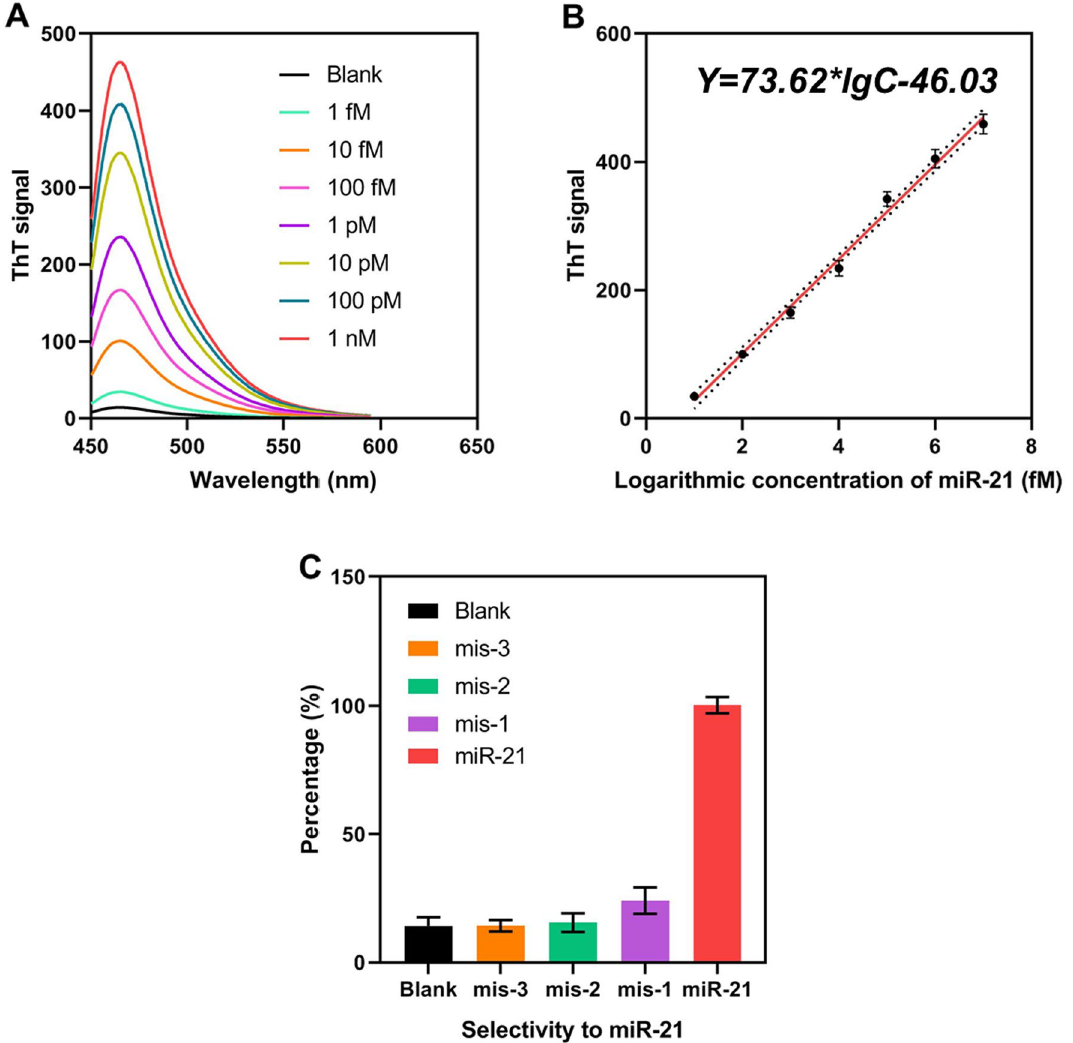
Fig. 4 Analytical performance of DiRCA. A fluorescence spectrum of DiRCA when detecting different concentrations of miRNA-21. B correlation equation between obtained ThT signal and logarithmic concentrations of miRNA-21. C percentage of recorded ThT signal of DiRCA between mismatched miRNAs and target